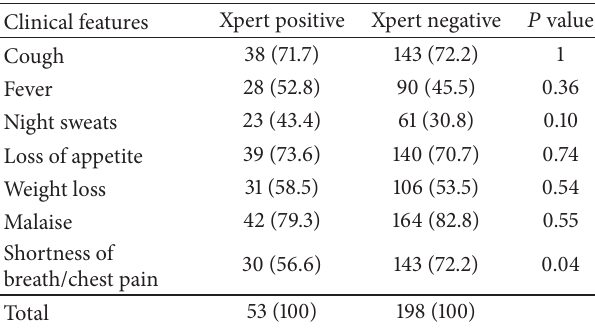
Table 1: Comparison of clinical features of 251 patients with suspected smear negative TB testing positive and negative by Xpert.